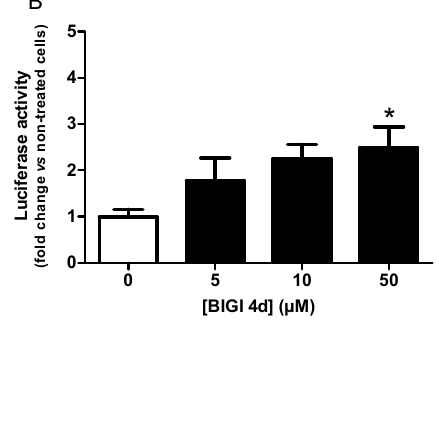
cytotoxicity of compounds against AREc32 cells were evaluated, showing no toxicity until